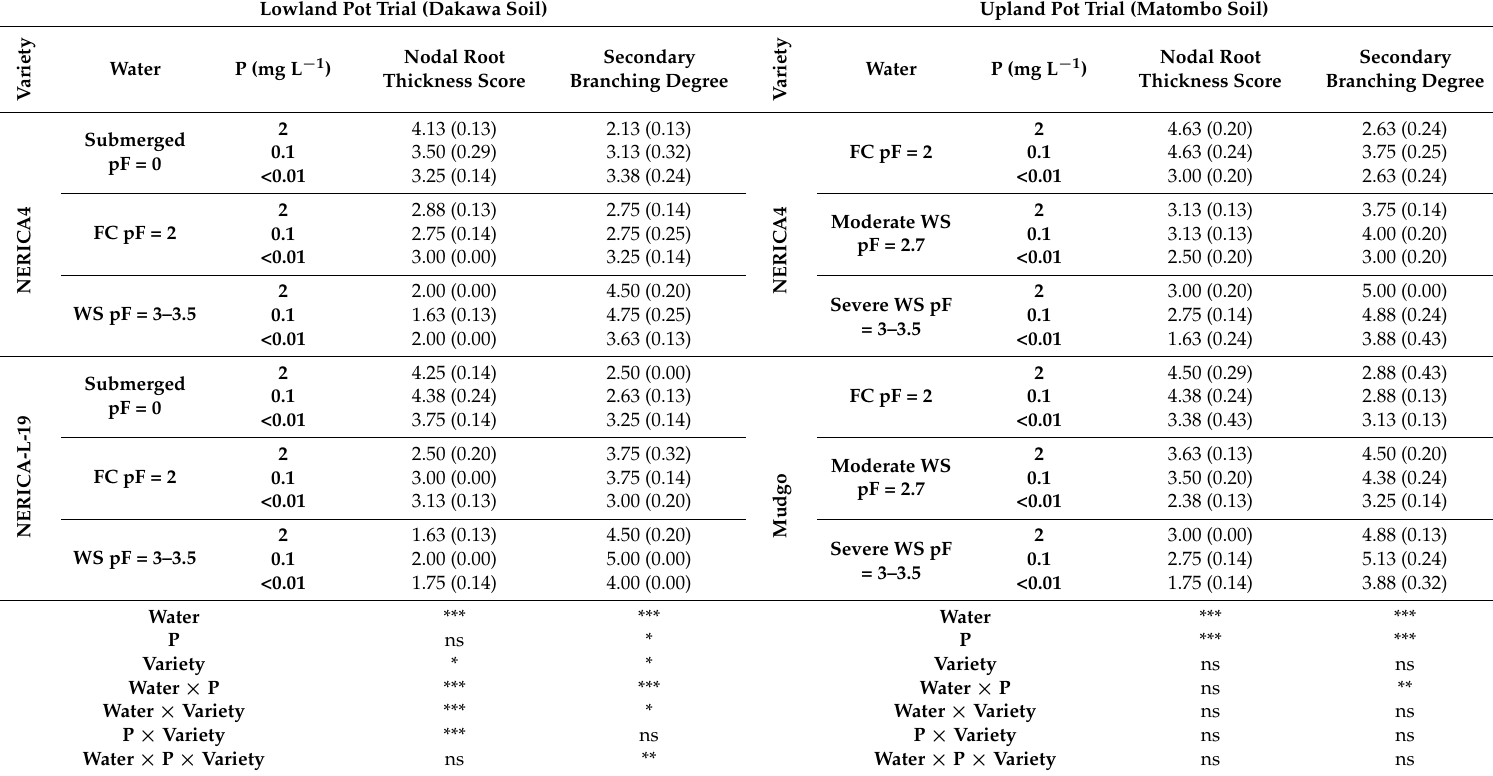
Table 4. The scores for the root architectural variables (i.e., nodal root thickness score, basal lateral root density score, and secondary branching degree) from both the lowland (left) and upland (right) pot trial. For the lowland trial two varieties, NERICA4 and NERICA-L-19, were grown under combinations of P rates (P concentration in the soil solution of <0.01 mg L − 1 , 0.1 mg L − 1 , and 2 mg L − 1 ) and water levels (water stress (WS), field capacity (FC), and submergence (Sub)). For the upland trial two varieties, NERICA4 and Mudgo, were grown under combinations of P rates (P concentration in the soil solution of <0.01 mg L − 1 , 0.1 mg L − 1 , and 2 mg L − 1 ) and water levels (severe water stress (severe WS), moderate water stress (moderate WS) and field capacity (FC)). All plants were harvested at 46 DAS. Data are presented as means with (standard errors). Probabilities of F-statistics for the effects of water, P and variety selection and their interactions on architectural the root variables in both trials are given at the